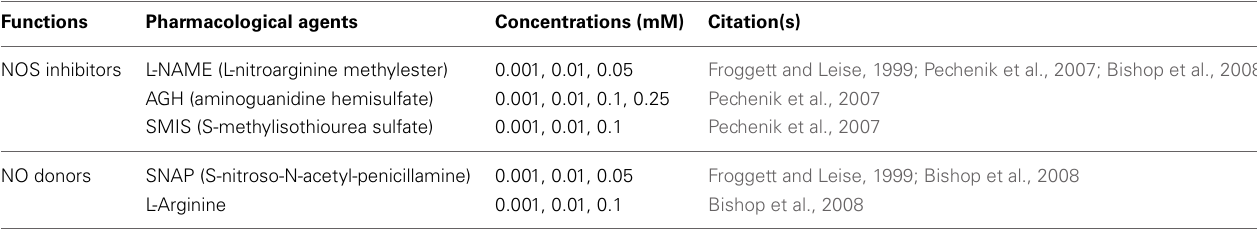
Table 1 | Summary of chemicals and their concentrations used in metamorphosis assay of Haliotis asinina .